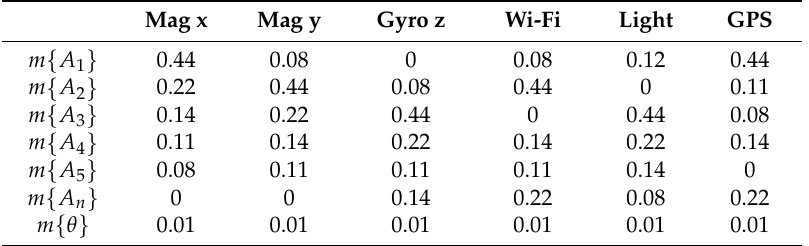
Table 6. Basic belief assignment of each sensor in the frame of discernment.